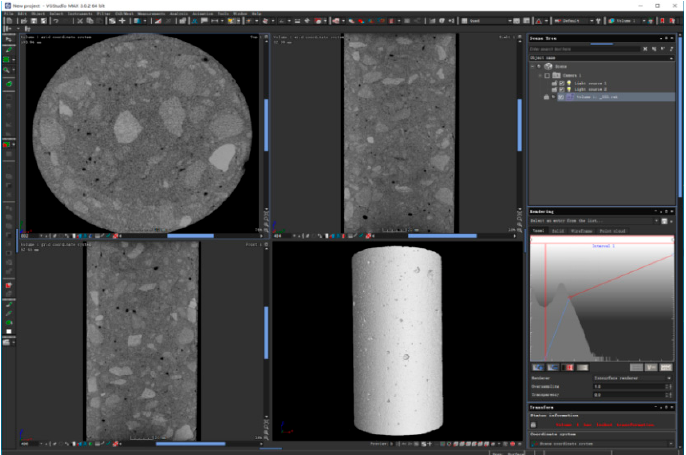
Figure 10. X-ray industrial computed tomography (ICT) scanning system.